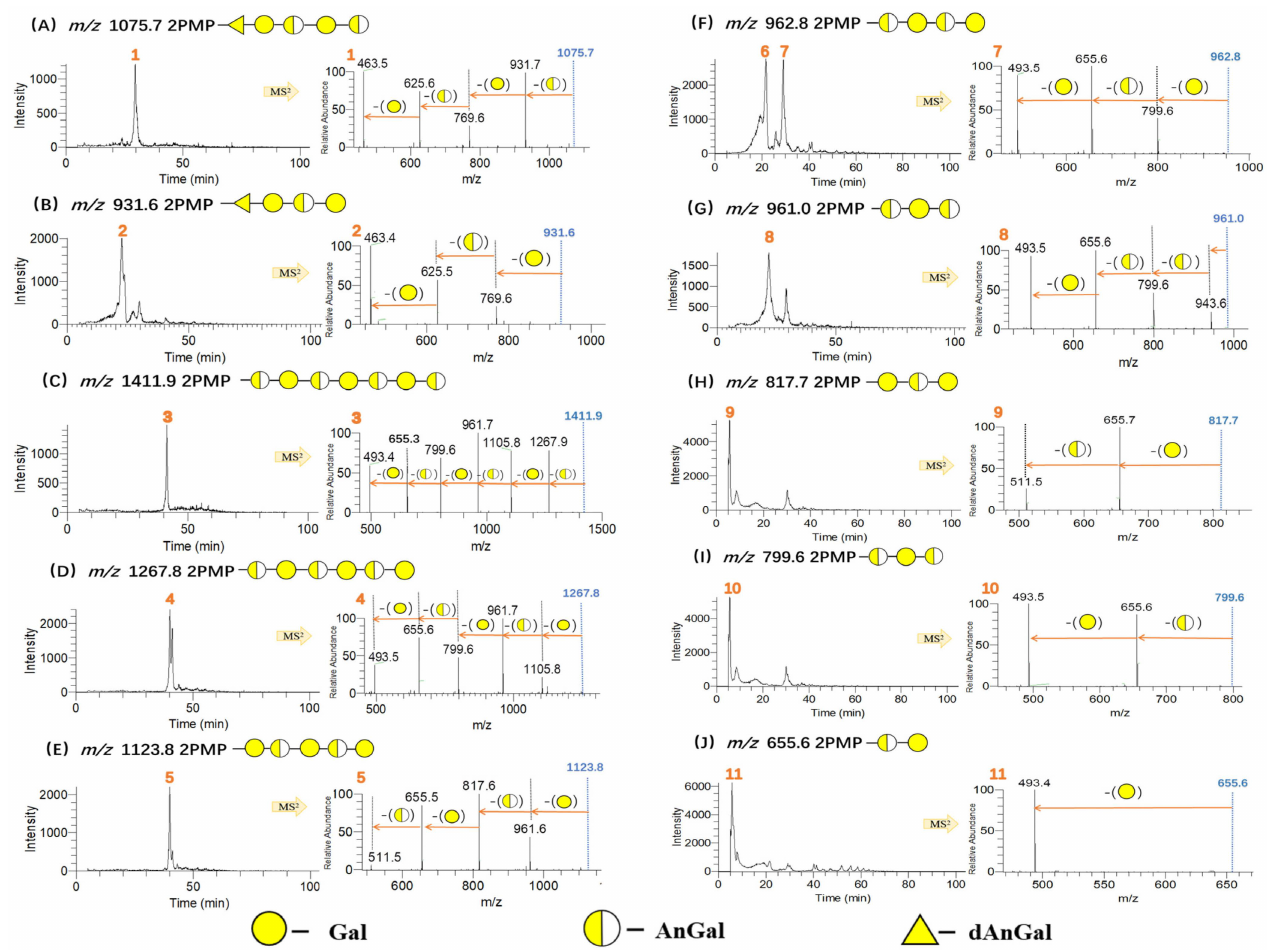
Figure 6. HPLC-MS n analysis results of carrageenan oligosaccharides in DC-6. The identified peaks are